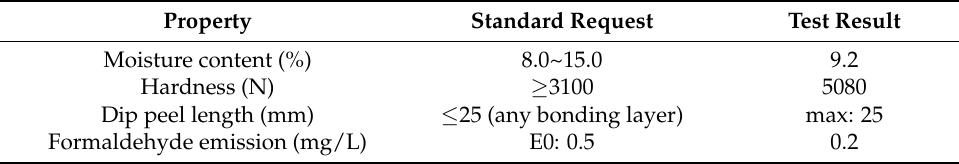
Table 1. Physical and mechanical properties of FBCB.